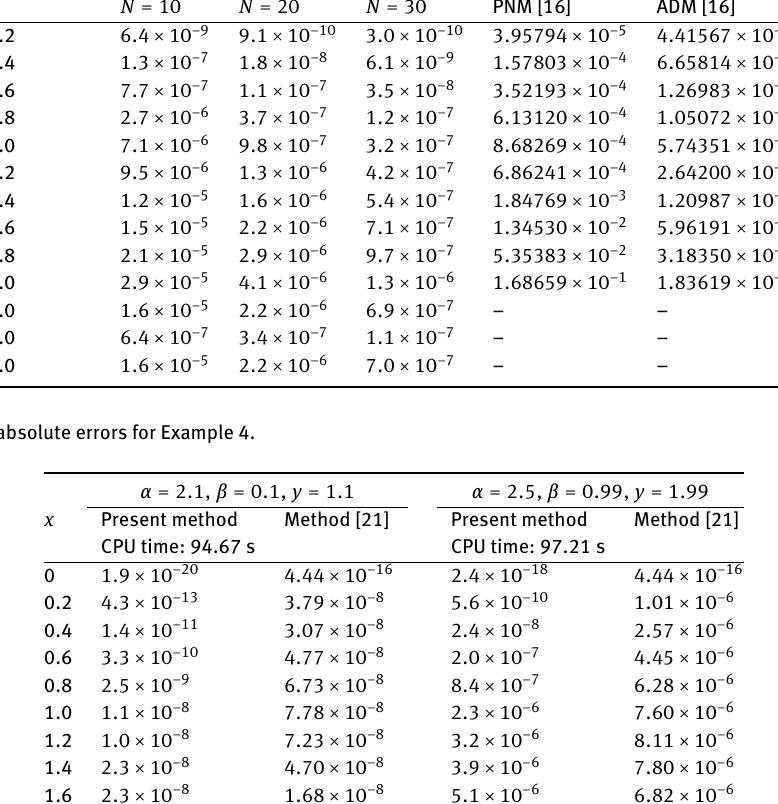
Table 5: Comparison of absolute errors for ( a = 1, b = 0.1, c = 0.2, e = 0.3, α 1 =